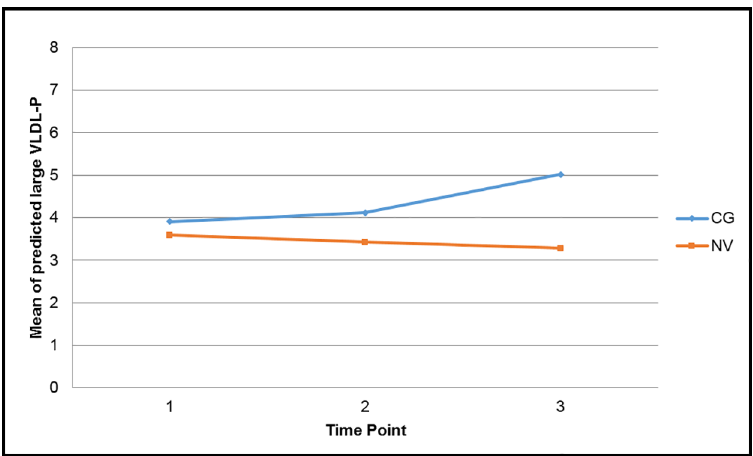
Fig 1. Predicted large VLDL-P particle concentration over time based on caregiver status, controlling for income. Contrast tests showedsignificantdifferences betweentime-point3 and time-point 1 ( p = .002) and betweentime-point 3 and time-point2 ( p = .0112) for caregivergroup only. CG caregiver, NV normal volunteer.